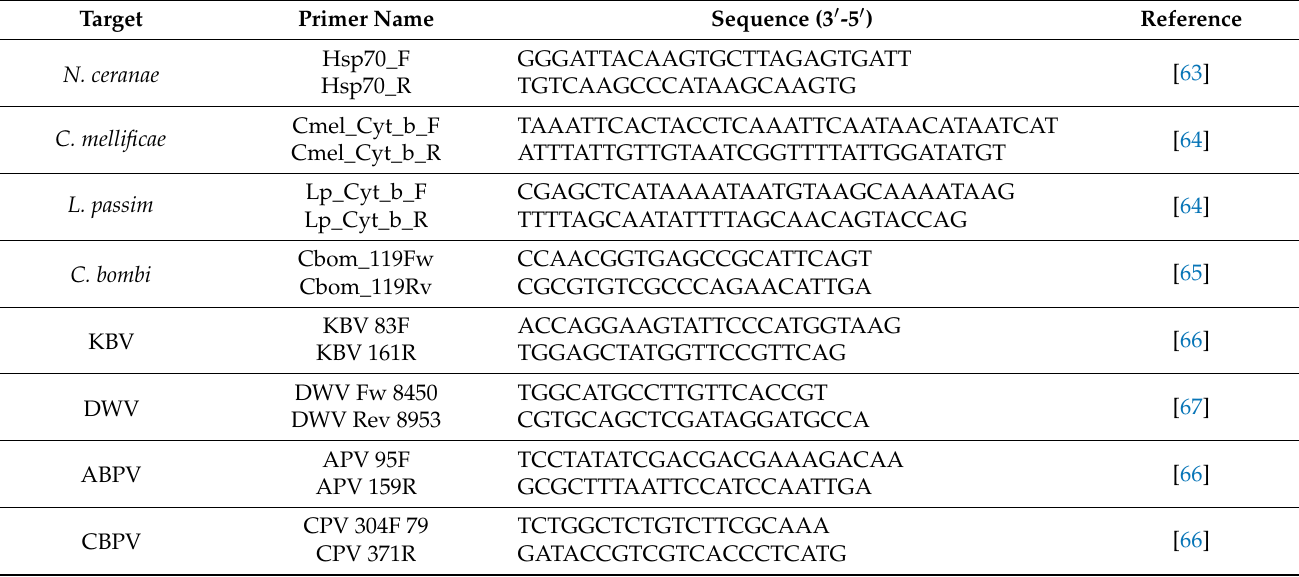
Table 2. List of the primers used to analyse the pathogens in this